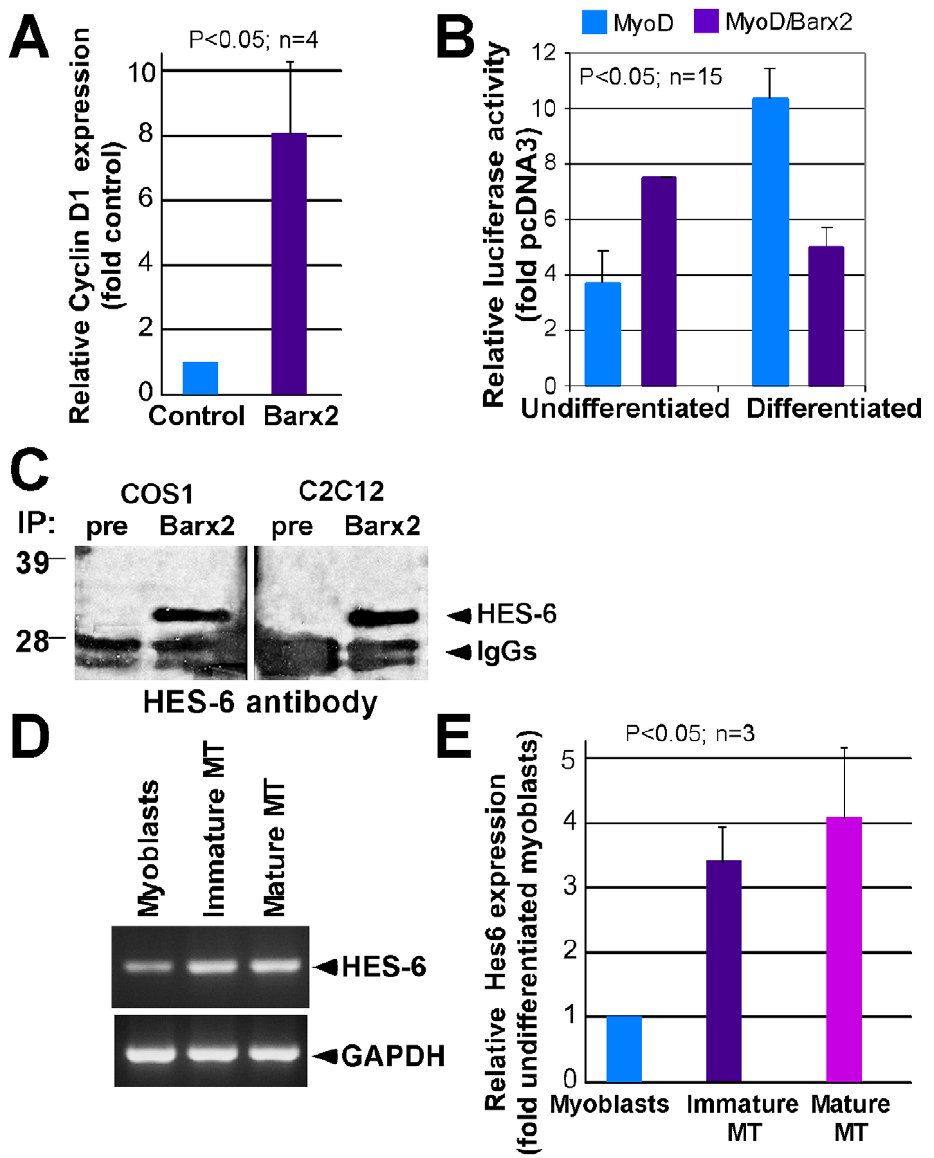
Figure 4. Regulatory connections of Barx2 during muscle differentiation. A. Quantitative RT-PCR analysis of cyclin D1 expression in C2C12 cells stably transfected with a Barx2-expression plasmid or control plasmid. B. The SMA promoter-luciferase construct was co-transfected with combinations of Barx2, MyoD, or empty pcDNA3 expression plasmids in C2C12 cells. Barx2 increased SMA promoter activation in undifferentiated cell cultures yet inhibited activation in myotubes. C. Co-immunoprecipitation was performed after expression of both Barx2 and Hes6 proteins in COS1 cells and C2C12 cells. Barx2 co-immunoprecipitated Hes6 in both contexts. D. Expression of Hes6 was compared in C2C12 myoblasts and myotubes using RT-PCR. Hes6 is upregulated in myotubes. E . Graphical representation of the RT PCR data shown in D (n – number of